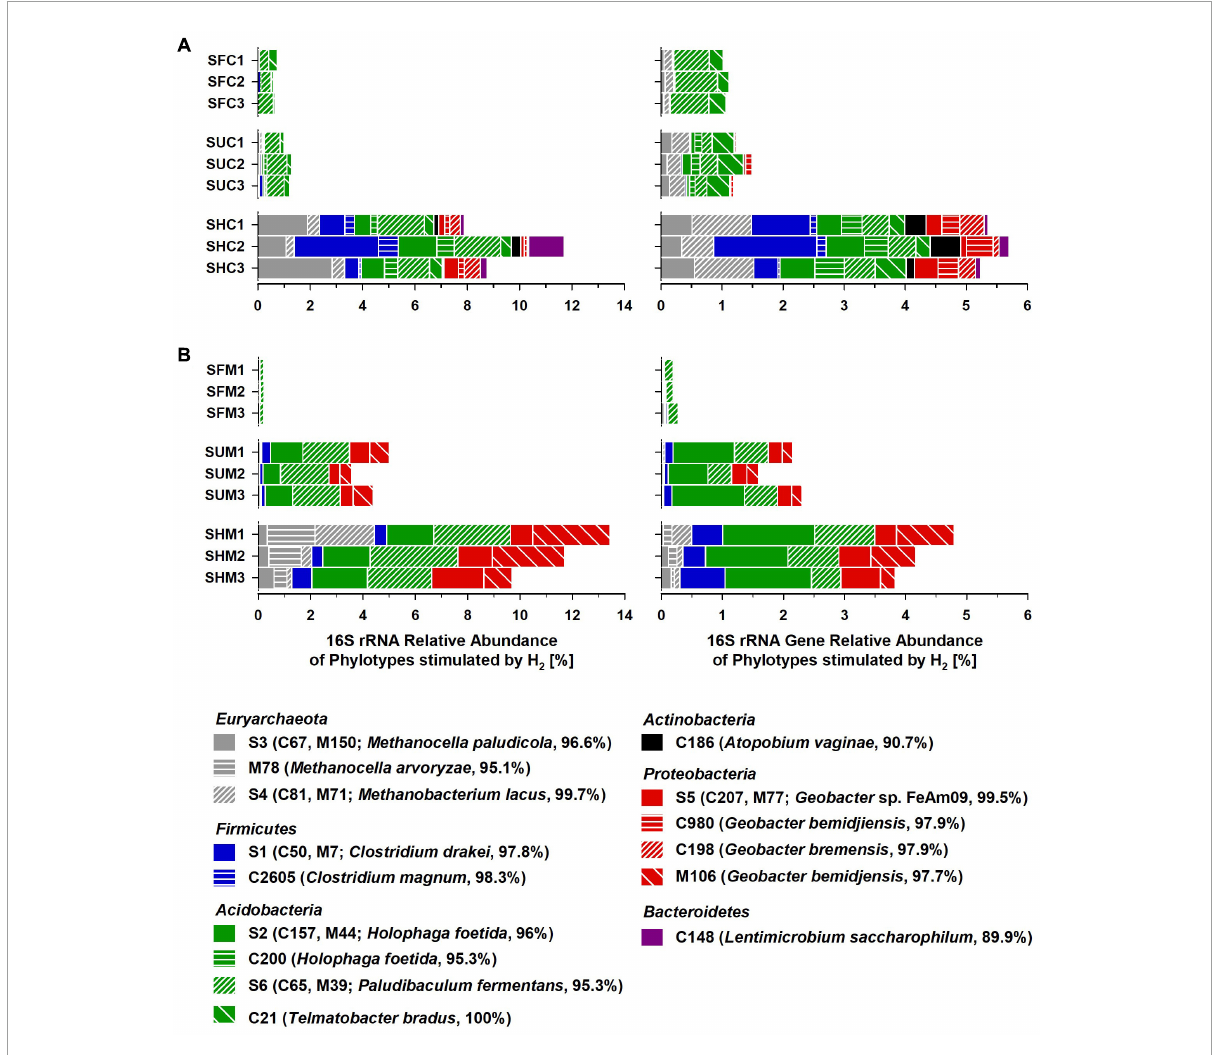
FIGURE3 Relative abundance of phylotypes stimulated by supplemental H 2 in Carex (A) and Molinia (B) soil treatments. Displayed phylotypes were considered as “stimulated by H 2 ” based on a manually refined LEfSe approach ( Table 2 ). Samples/Treatments: SFC, fresh Carex soil; SUC, unsupplemented Carex soil; SHC, H 2 supplemented Carex soil; SFM, fresh Molinia soil; SUM, unsupplemented Molinia soil; SHM, H 2 supplemented Molinia soil; numbers specify replicates. Phylotype identifiers: C/M, phylotypes from experiments with Carex / Molinia soil; S, shared phylotypes (i.e., Carex phylotypes that shared 100% 16S rRNA gene sequence similarity with Molinia phylotypes; Figure 2 ); closest cultured relatives and BLASTn identities are given in